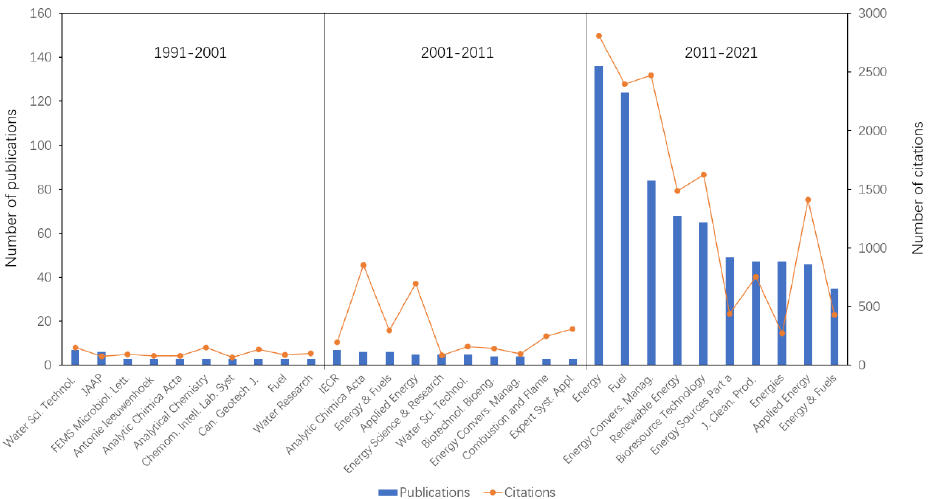
Figure 8. Journals with the most publications and citations in AI in bioenergy research for the last three decades.